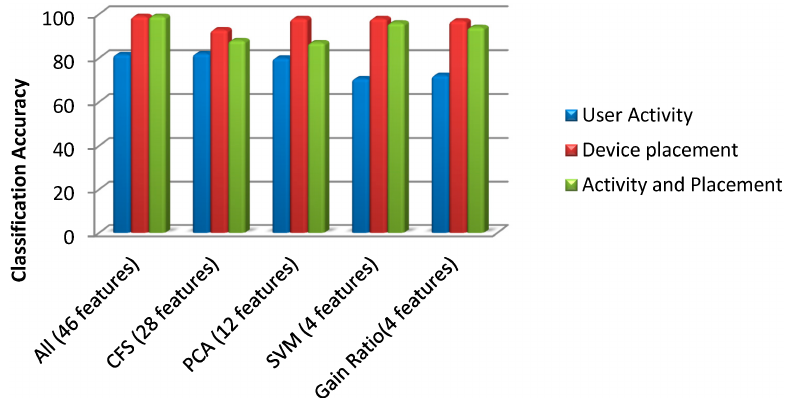
Figure 11. Recognition accuracy using different number of features for different activity modes (Classifier: Bayesian Network, Number of features: 46). Table 7. Selected feature using SVM and Gain Ratio feature evaluator and their corresponding recognition accuracy (Classifier: BN).